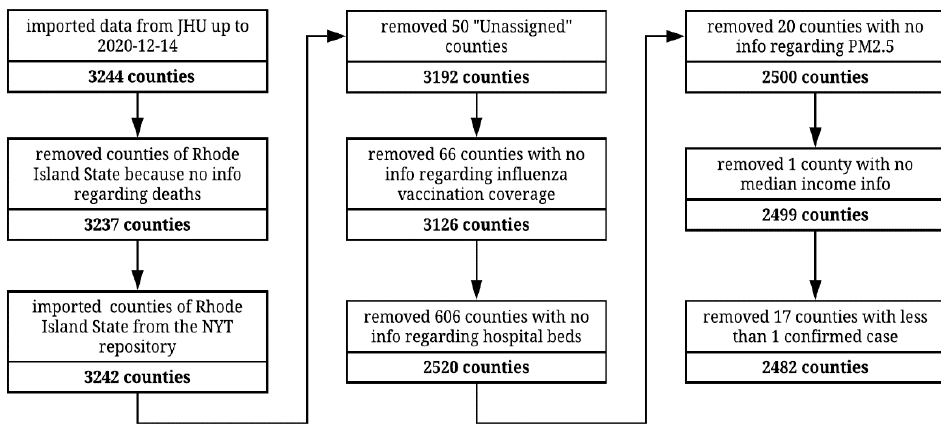
Figure 1. Steps of data collection and processing. Initial dataset comprised 3244 counties. COVID-19 data up to 14 December 2020 were imported from Johns Hopkins University repository. Since this repository does not report Rhode Island COVID-19-related deaths at the county level, that information was obtained from the New York Times repository instead. Counties with missing information regarding the variables of interest or confounders and those with zero cases were excluded from analysis. The final dataset used for the main analysis comprised 2482 counties.